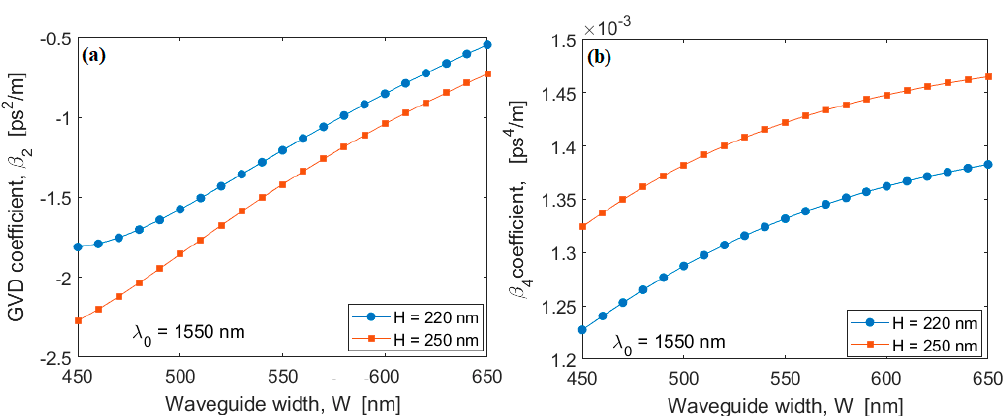
Figure 2. Group Velocity Dispersion (GVD) coefficient spectrum for different values of the SOI waveguide width, assuming 𝐻 = 220 nm (solid line) and 𝐻 = 250 nm (dashed line).